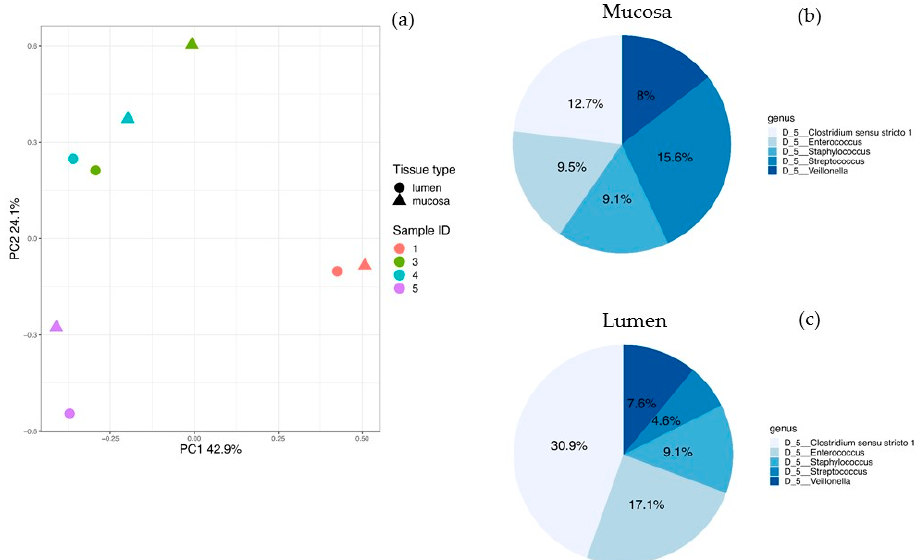
Figure 1. PCoA clustering and the most abundant genera in human samples. ( a ) PCoA plot with weighted UniFrac analysis of human luminal and mucosa samples revealed clustering according to the proband rather than the tissue type. Dot colors indicate the different probands, circles are lumen-derived samples and triangles are mucosa-derived samples. Pie chart of the five most abundant genera of the ( b ) mucosal and ( c ) luminal bacterial